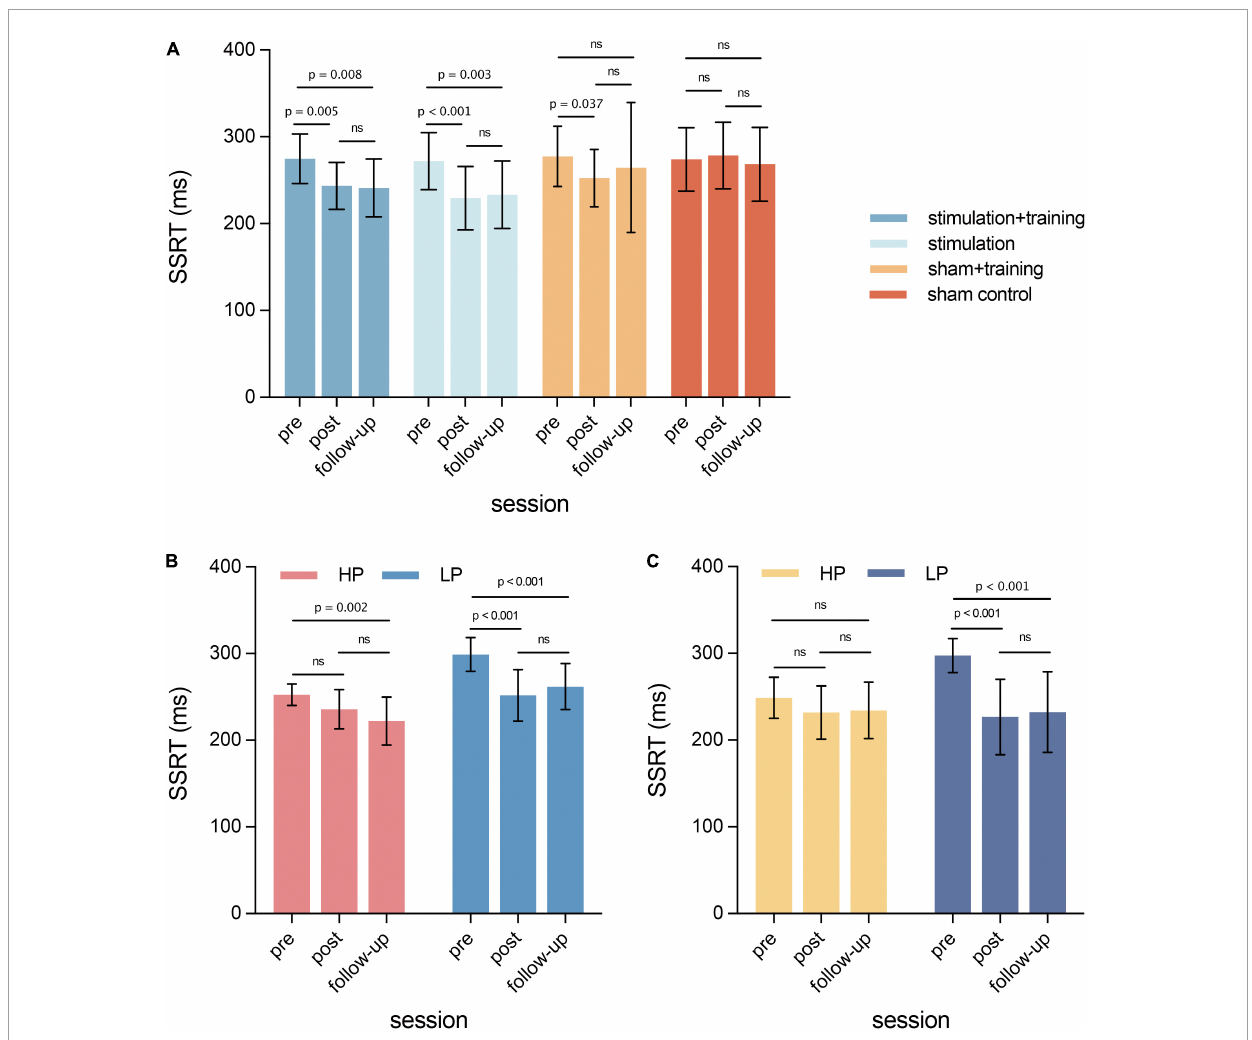
FIGURE4 The effects of different intervention conditions in relation to the stop-signal task. (A) Significant interaction between group and time. (B) Subgroup analysis in the stimulation + training group. (C) Subgroup analysis in the stimulation group. HP, high performance; LP, low performance. All error bars represent standard